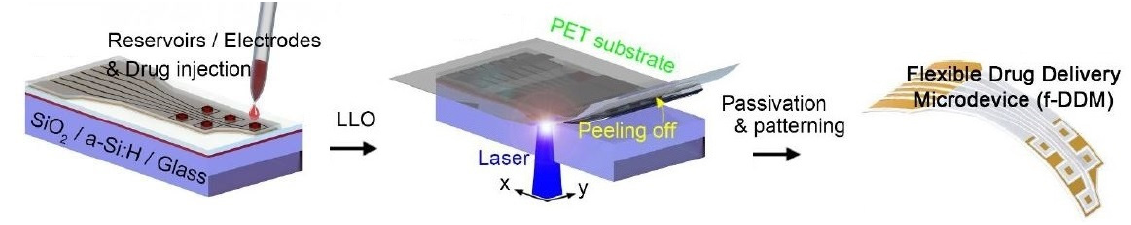
Figure 8. Illustration of the fabrication of flexible drug delivery micro-devices [153].